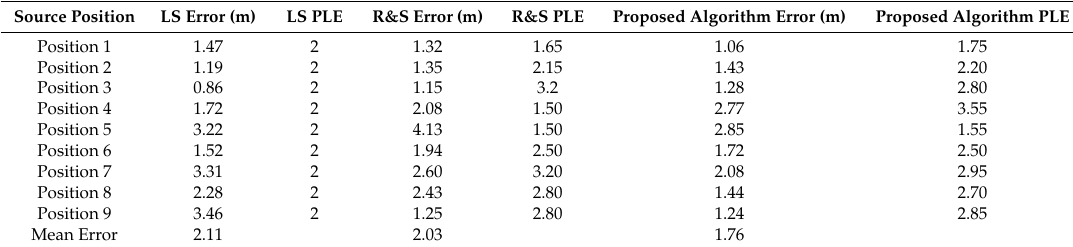
Table 8. Error and PLE comparison for eight measurement sensors.